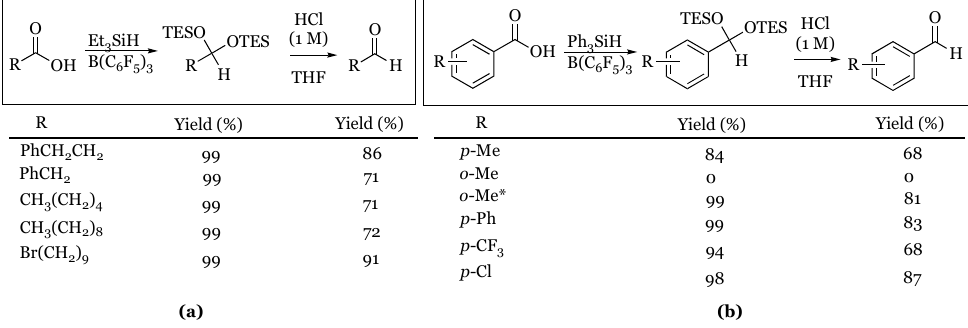
Figure 6. Conversion of carboxylic acids into aldehydes: ( a ) aliphatic carboxylic acids; ( b ) aromatic carboxylic acids; * Triethylsilane used in place of triphenylsilane.